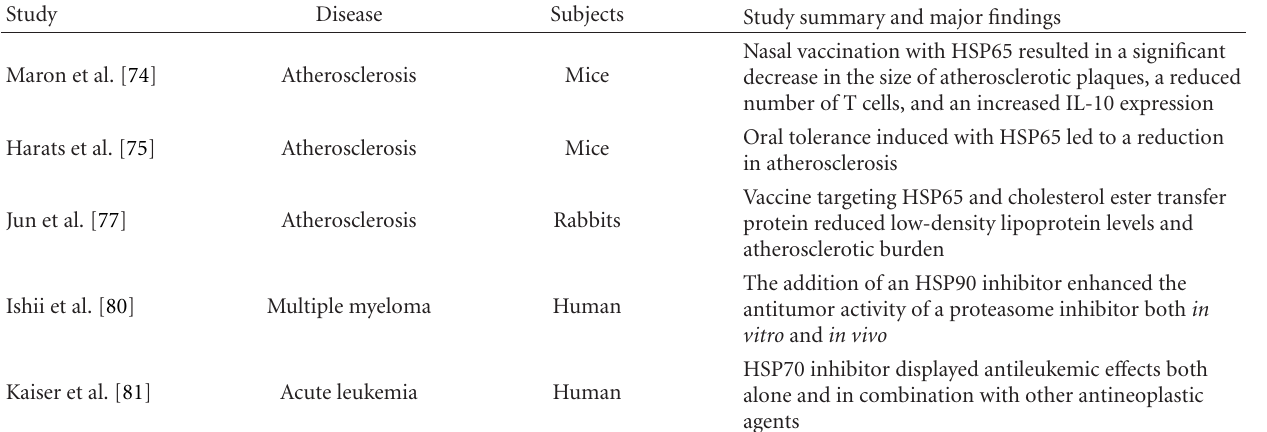
Table 4: Summary of studies on potential heat shock protein-related treatments for various diseases. Study Disease Subjects Study summary and major findings